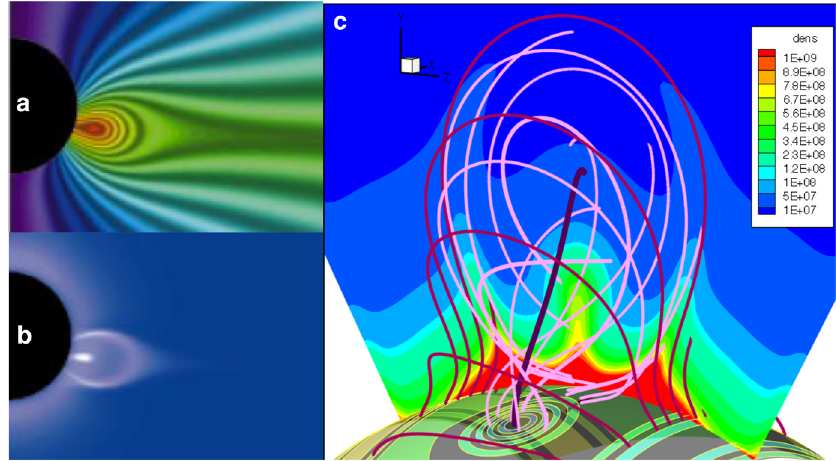
Fig. 14 Simulations in which cavities arise from pre-eruption magnetic flux ropes. a Magnetic field lines and b line-of-sight integrated polarized brightness simulation. Image reproduced with permission from Linker et al. (2003), copyright by AIP. c Field lines with central cut showing cavity in density (after Gibson and Fan